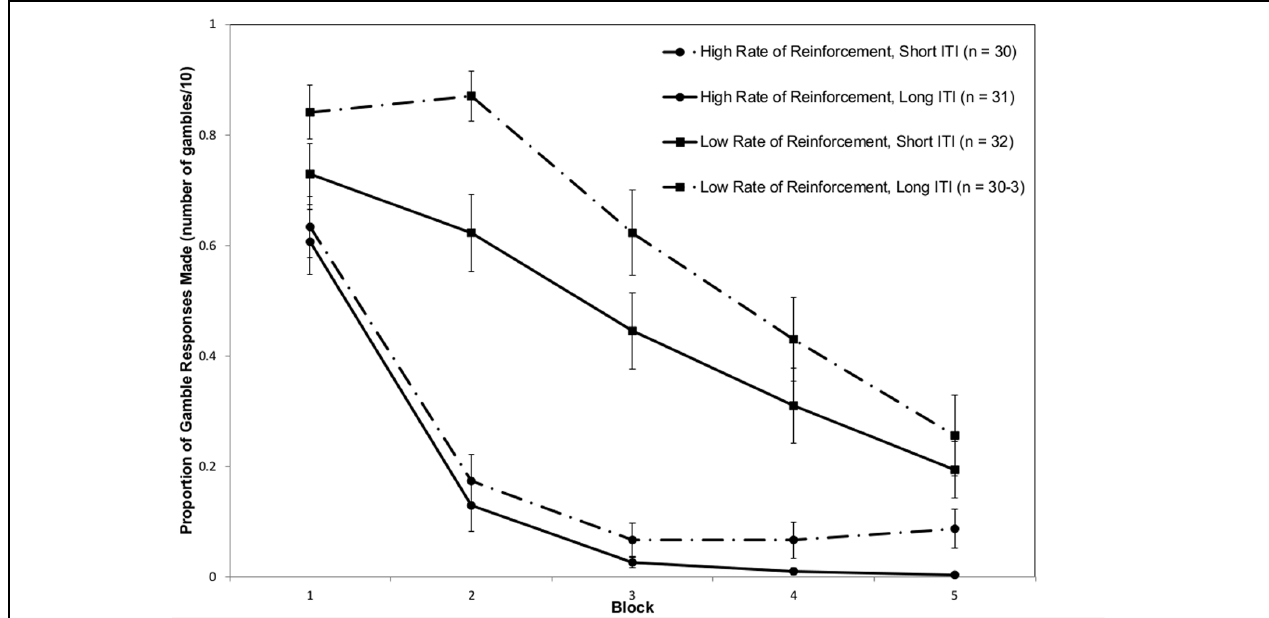
FIGURE 2 | Plot of extinction data for all groups, in blocks of 10